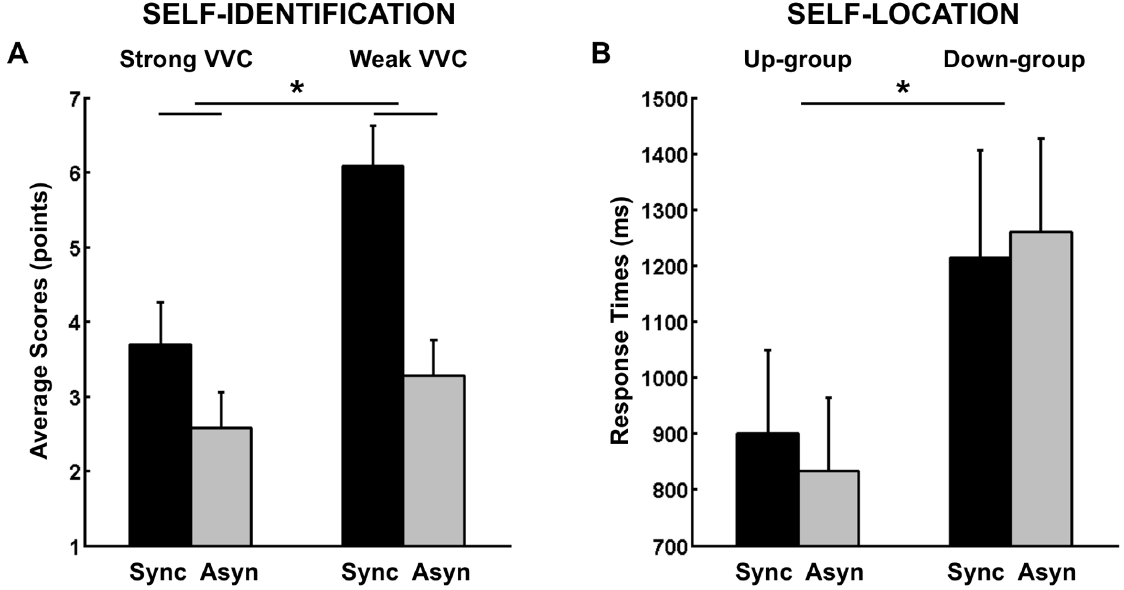
Figure 2. Results of Experiment 1. (A) Average self-identification ratings for the synchronous (Sync) and asynchronous (Asyn) visual-tactile stroking and for the strong and weak visual-vestibular conflict (VVC). (B) Self-location results showing average response times in the Mental Ball Dropping task. Error bars indicate standard errors of the mean.